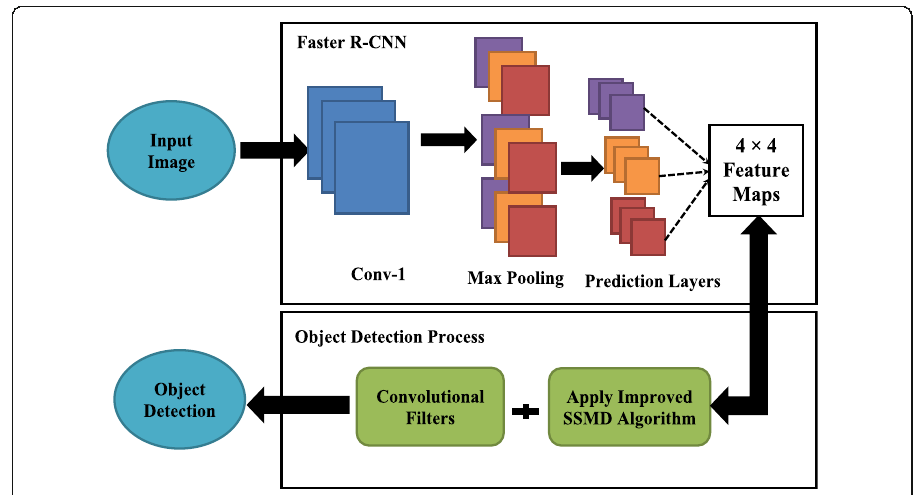
Fig. 3 The proposed system model. The training set of improved SSD algorithm depends upon three main sections, i.e., selecting the size of box, matching of boxes, and loss function. The proposed scheme can be understood by the system model given in Fig.